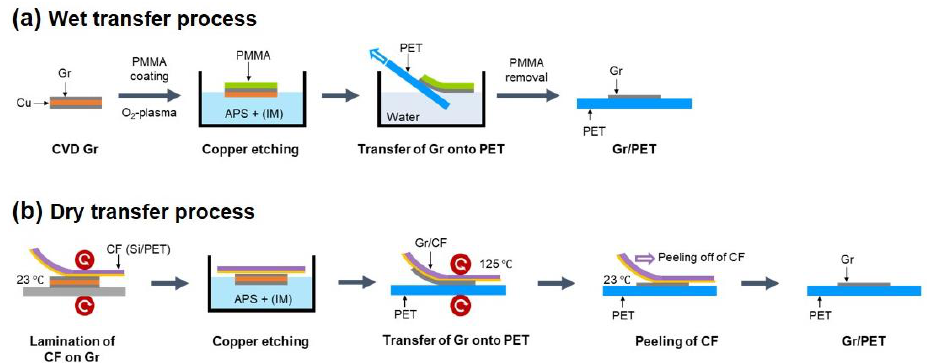
Figure 1. Schematics showing the fabrication processes of the Gr/PET films with two conventional Gr transfer methods. ( a ) Wet transfer and ( b ) dry transfer methods.